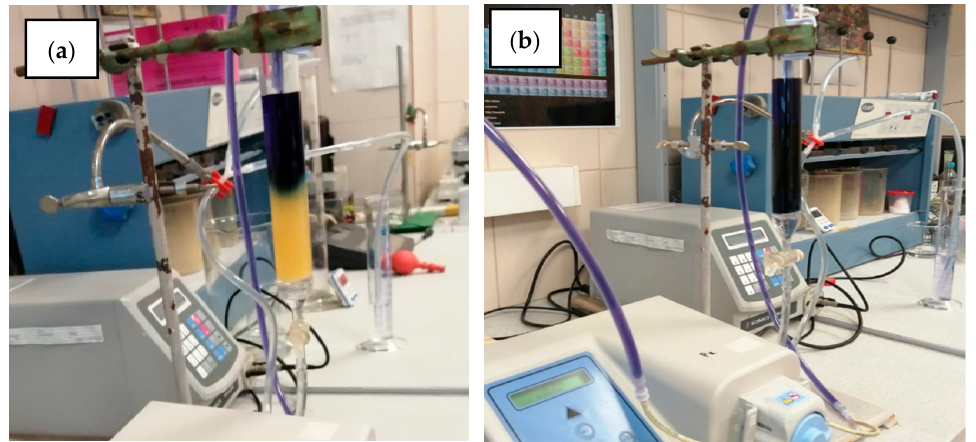
Figure 7. Pilot continuous mode adsorption installation at the National Research and Development Institute for Industrial Ecology (ECOIND) laboratory: ( a ) loaded bed column after 174 h of continuous solution flow; ( b ) loaded bed column after 348 h of continuous solution flow of AB